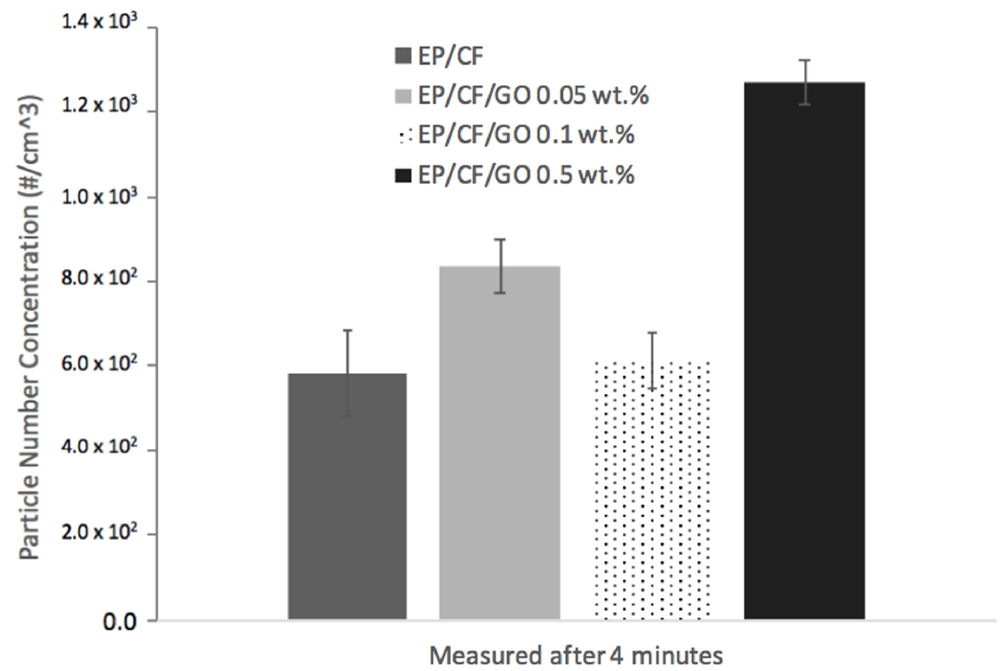
Figure 4 . Particle number concentration recorded at 4th min (#/cm 3 ) for EP/CF-based samples = 3 for each reinforced with GO as measured on the CPC (n = 3 for each average). with GO as measured on the CPC ( n